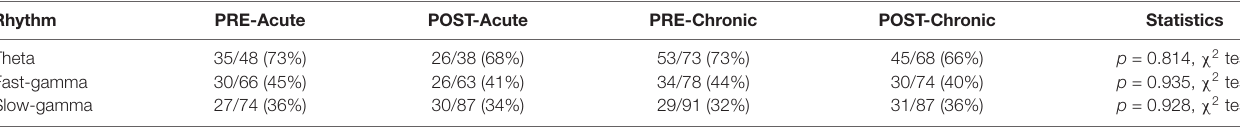
TABLE 2 | Distribution of place cells phase-locked to theta and gamma oscillations on day-1 and